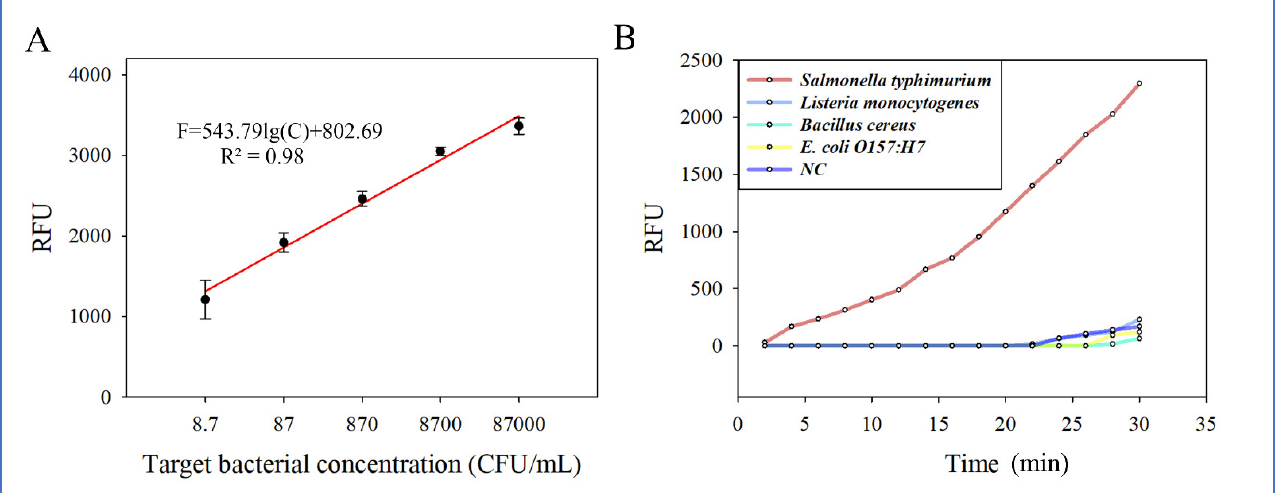
Figure 5. Performance of the biosensor. ( A ) The calibration curve of the biosensor (N = 3). ( B ) Specificity of the biosensor (N = 3).